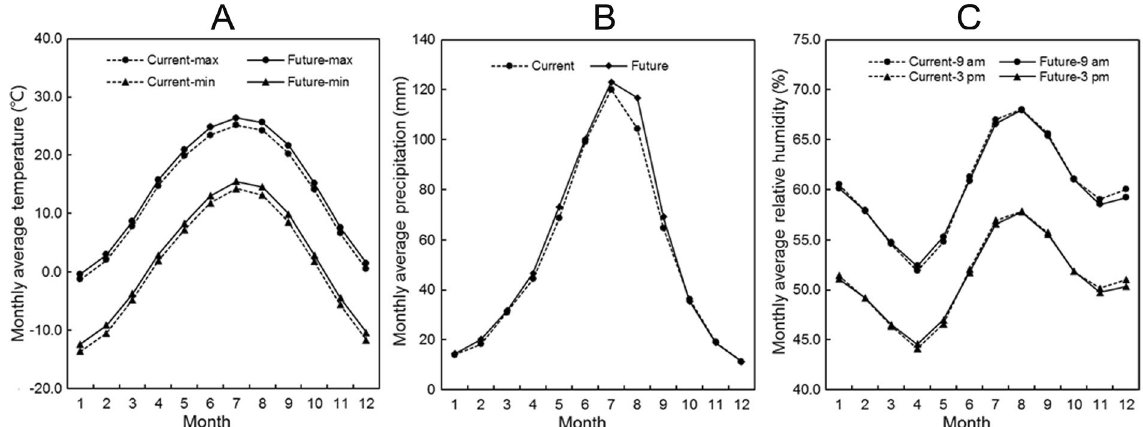
Figure 9. Monthly average climate data under the current (1981–2010) and future (2011–2040) conditions in China. The five groups of climate data which were divided into three classes were the current and future climate data we used to predict the potential distribution in this study.